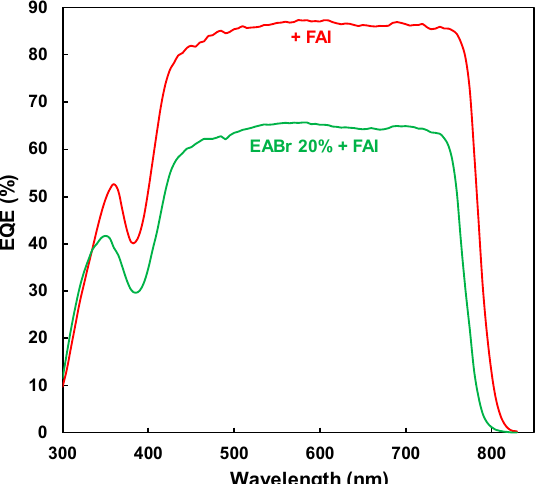
Figure 6. External quantum efficiency spectra of the fabricated solar cells.